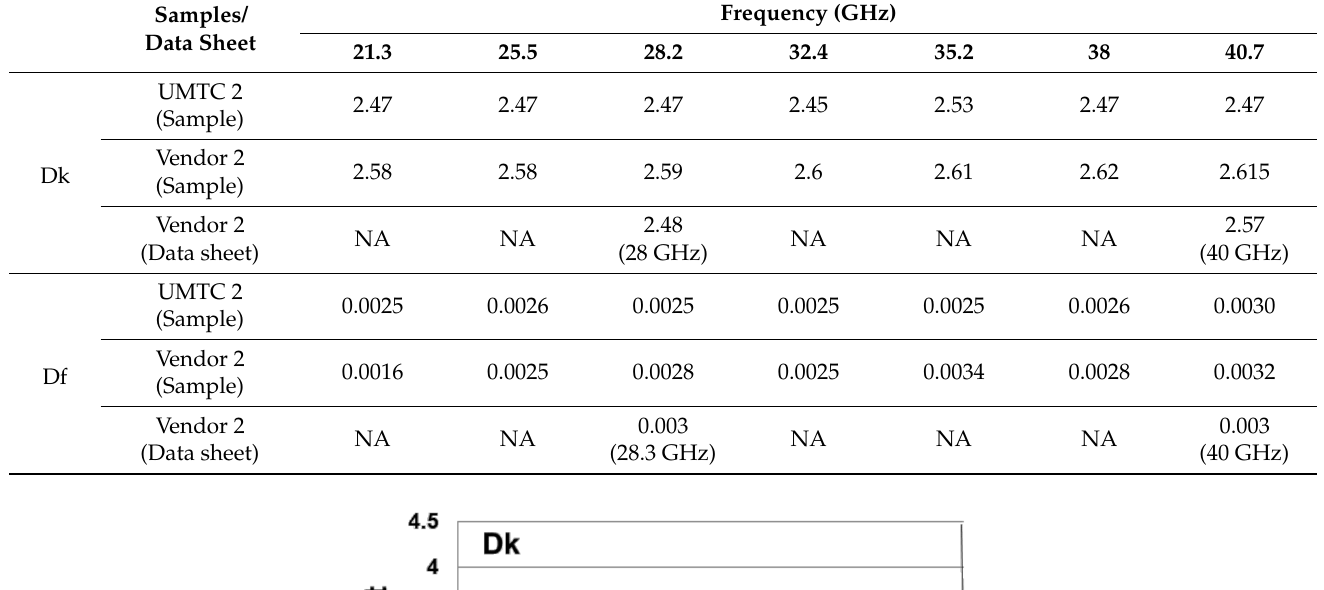
Table 4. Dk and Df of Vendor 2.